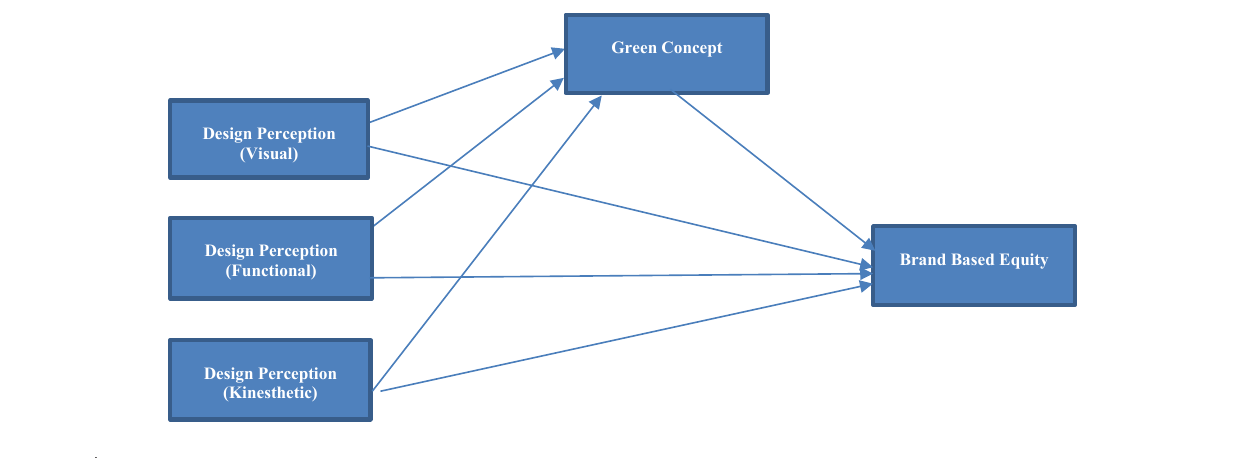
FIGURE 1 | Conceptual